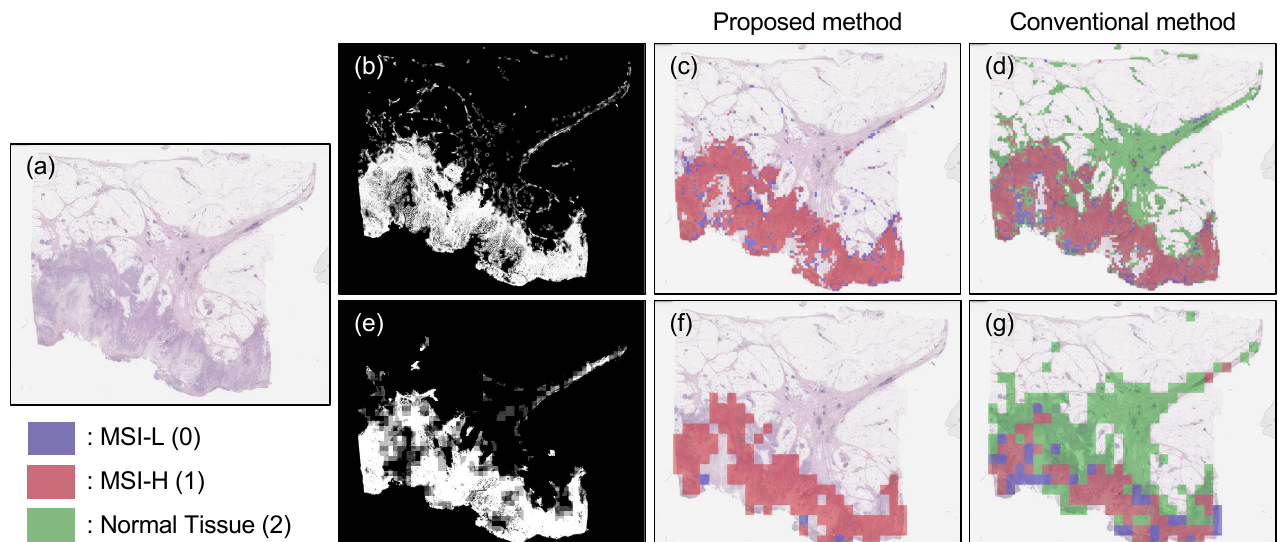
Figure 4. Patch-wise classification results of the MSI-H tissue, which were predicted as MSI-H for both the proposed and the conventional method. ( a )The original WSI. The segmented tumor mask and the heatmap created using the proposed method and the conventional method with images at 20 × magnification( b – d ) and 10 × magnification( e – g ).